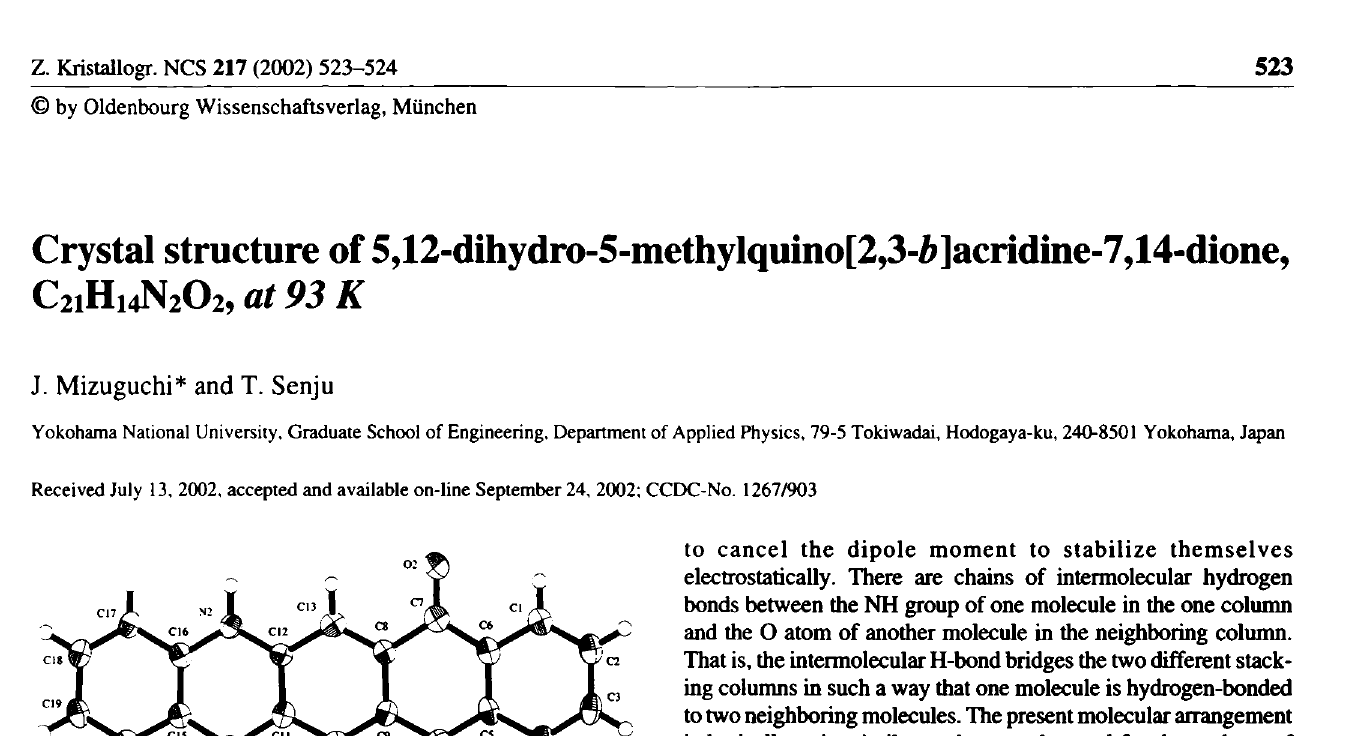
Table 1. Data collection and handling.